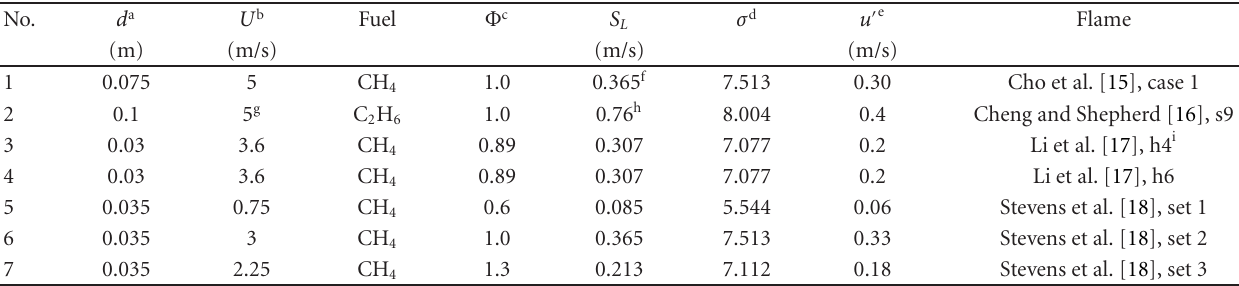
Table 1: Experimental conditions.